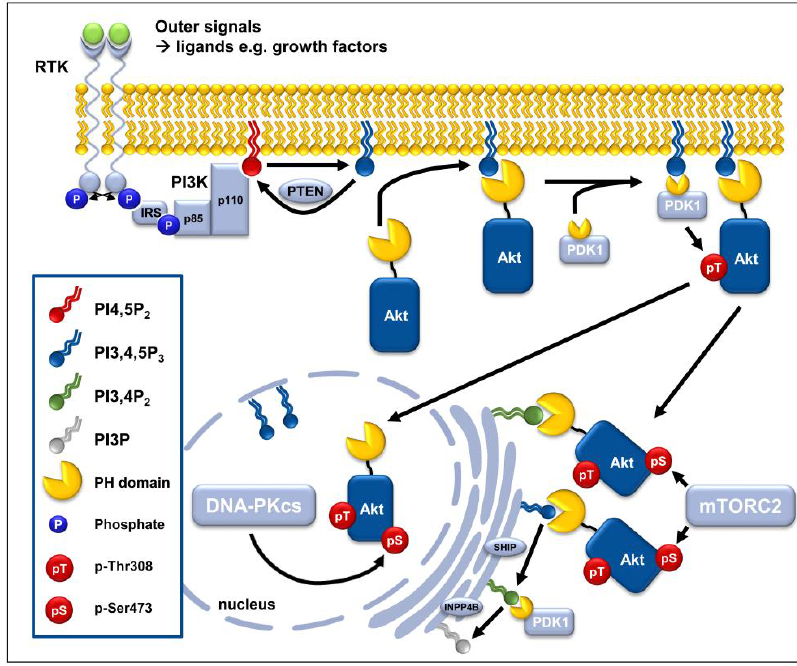
Figure 1. Schematic representation of compartmentalized Akt activation. PI(3,4,5)P 3 production at the cell membrane depends on PI3K that is activated downstream of active RTKs and GPCRs.